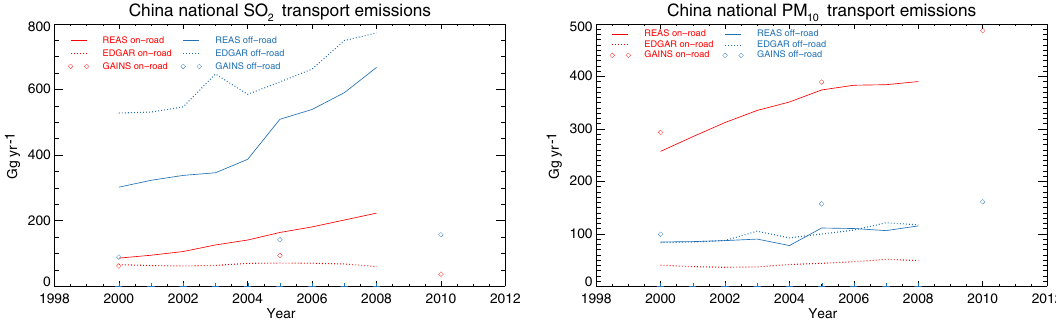
Figure 13. National on-road and off-road transport sector emissions of SO 2 and PM 10 estimated by REAS, EDGAR, and GAINS between 2000 and